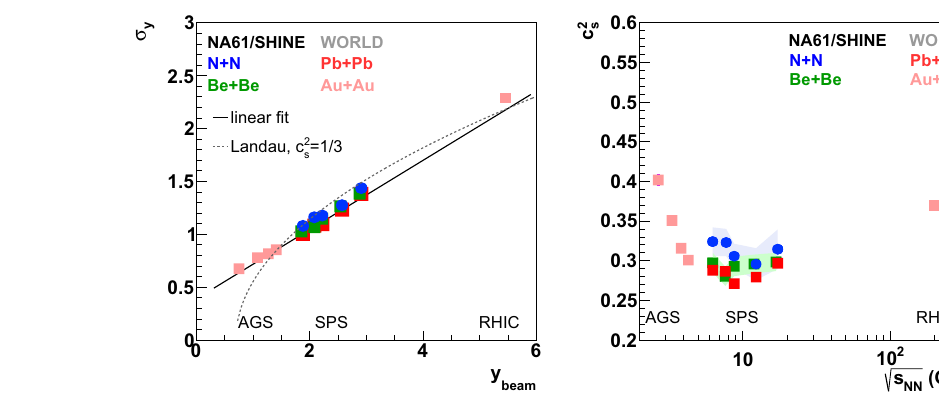
charged pions in p+p [13,34] (denoted as N+N ) as a function of the beam rapidity y beam . The dotted line indicates the Landau model pre- diction with c 2 s = 1 / 3, while the full line shows a linear fit through the data points. Right: The speed of sound as a function of beam energy as extracted from the data using Eq.